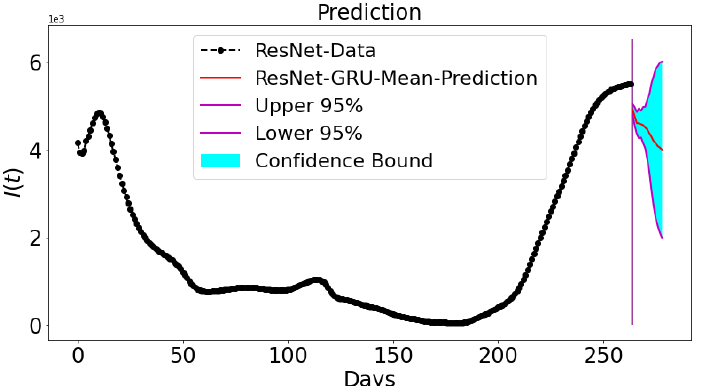
Figure 19. A confidence interval is constructed for a short-term prediction using